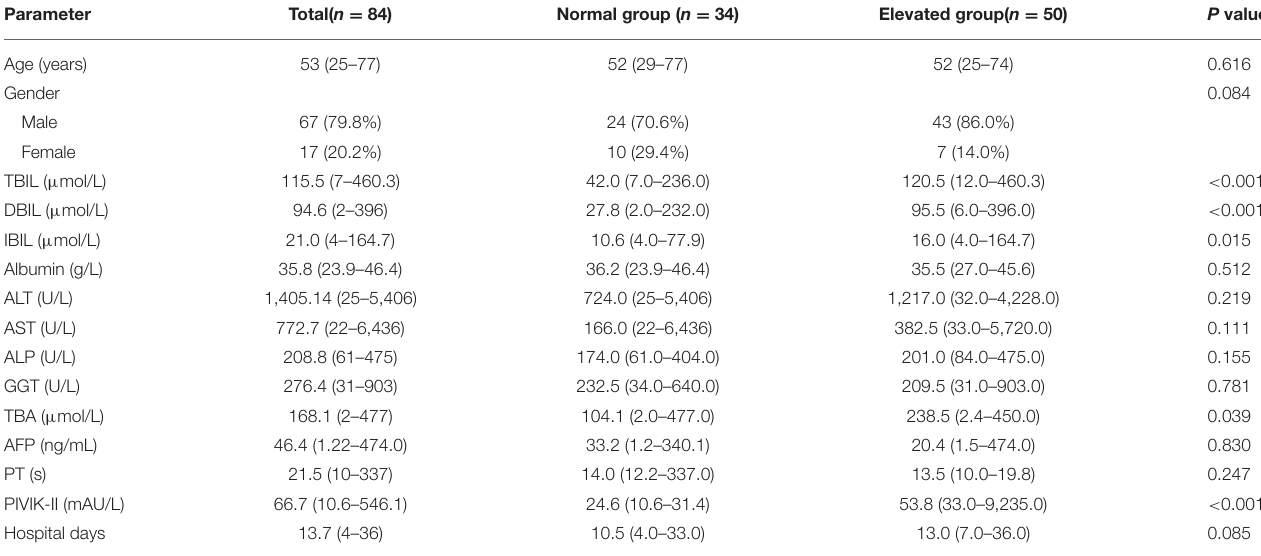
Median (min–max) for continuous variables: the p was calculated by the linear regression model. N (%) for categorical variables: the p was calculated by the chi-square test. p < 0.05 was considered statistically significant. TBIL, total bilirubin; DBIL, direct bilirubin; IBIL, indirect bilirubin; TBA, total bile acid; ALT, alanine aminotransferase; AST, aspartate